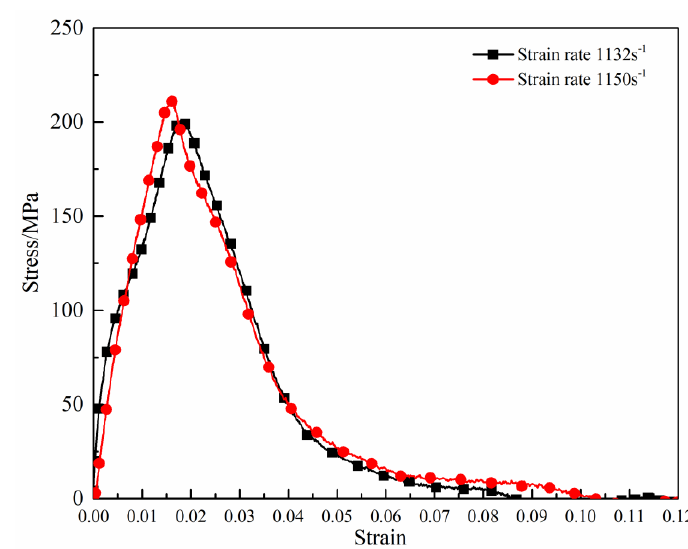
Figure 7. Contrast of the stress-strain curves for the specimens of 14 cyclic hygrothermal aging days under the same pressure 0.6 MPa.